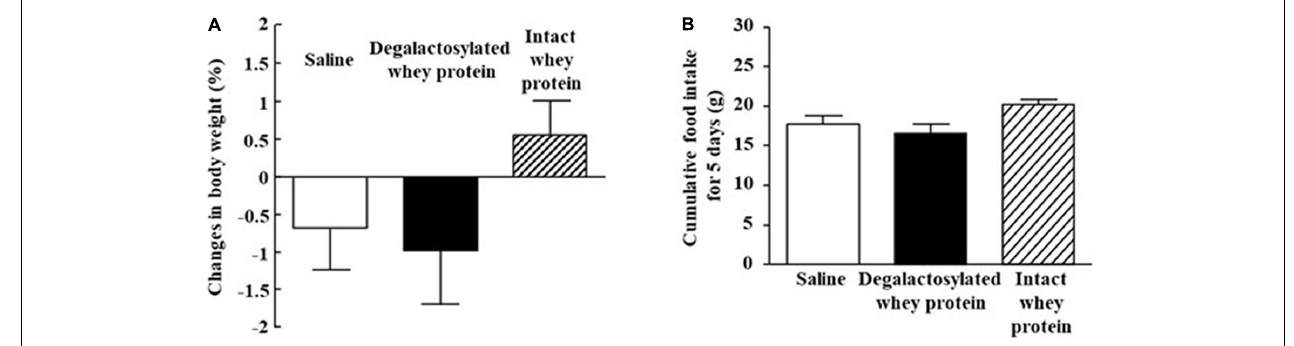
FIGURE 2 | Effects of intraperitoneal administration of degalactosylated whey protein for 5 days on body weight and food intake in mice. (A) Body weight changes (%) in mice after intraperitoneal treatment of intact and degalactosylated whey proteins (10 mg/kg) for 5 days. (B) Cumulative food intake in mice intraperitoneally treated with intact and degalactosylated whey proteins (10 mg/kg) for 5 days. Results are expressed as mean ± SE for 8–12 mice.